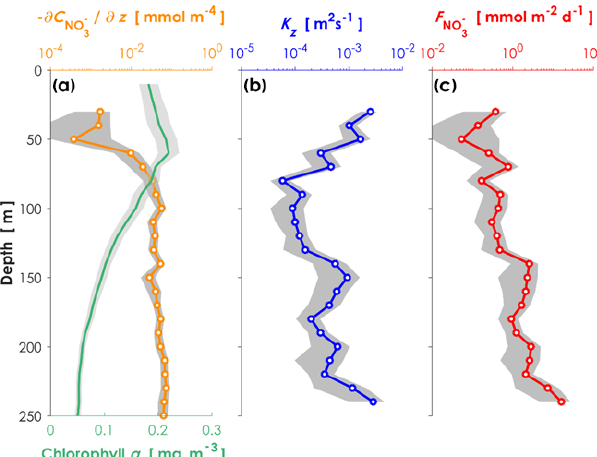
Figure 2. Vertical profiles of environmental conditions in the Kuroshio Current. (a) Nitrate gradient curve (orange) and chloro- phyll a concentrations (green) measured with a nitrate sensor (Deep SUNA V2) attached to an SBE 911plus CTD system. (b) Turbulent diffusivity measured with a TurboMAP-L (blue). (c) Calculated tur- bulent nitrate fluxes (red) in the ECS-Kuroshio. The shaded areas are the 95% confidence intervals obtained by a bootstrap